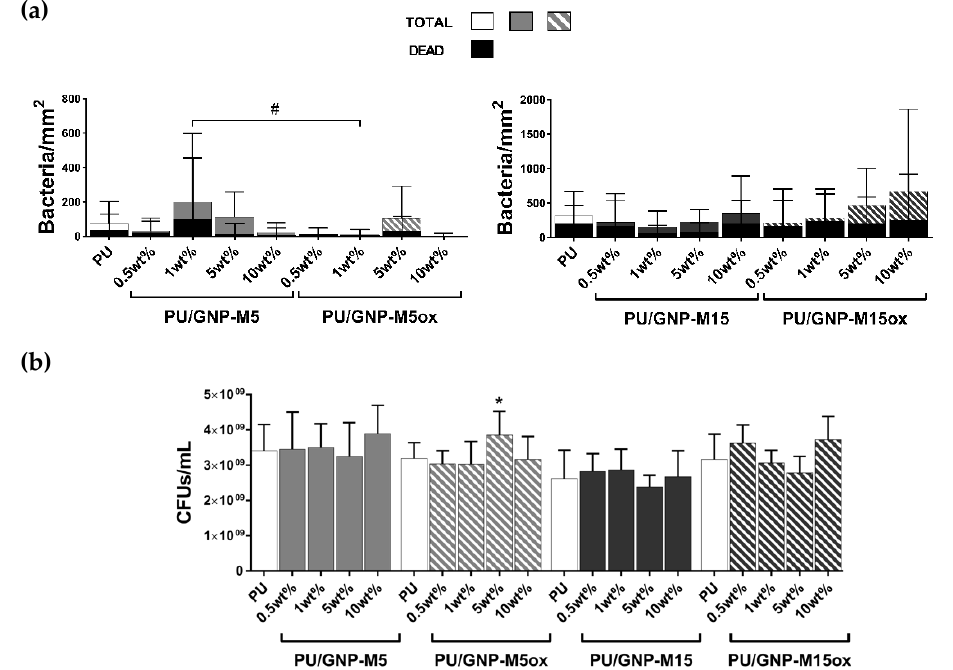
Figure 4. Antibacterial activity of PU/GNP composites after 24 h incubation with S. epidermidis : ( a ) total and dead adherent bacteria per mm 2 determined after total/dead staining and ( b ) planktonic viable bacteria collected in supernatant determined through viable cell counting. * and # statistically significantly different from PU (control) and differences between samples, respectively (Kruskal–Wallis (A) and one ‐ way ANOVA (B); p ≤ 0.05).